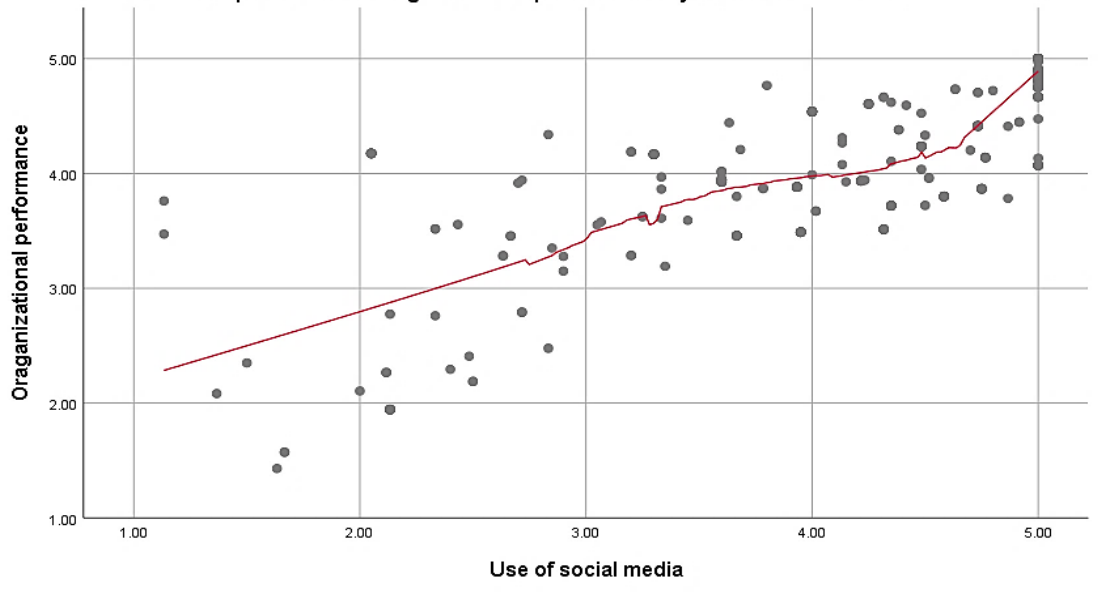
Figure 4. Simple scatter of organizational performance by use of social media.